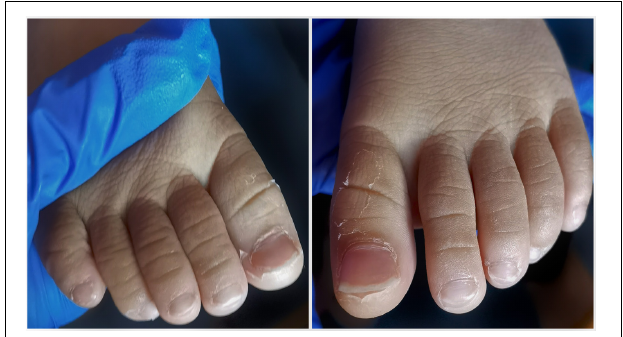
FIGURE 1 | Periungual peeling of skin in both